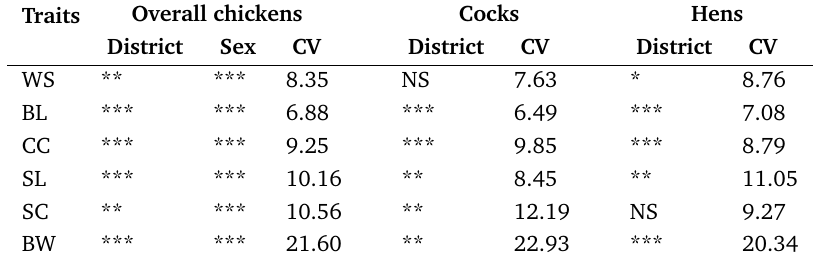
Table 3. Level of significance for the overallanalysis and separately for each sex. WS = Wingspan, BL = Body length, CC = Chest circumference, SL = Shank length, SC = Shank circumference, BW = Body weight, *p < 0.05, **p < 0.01, ***p < 0.0001, NS = Not Significant, CV = Coefficient of variation.